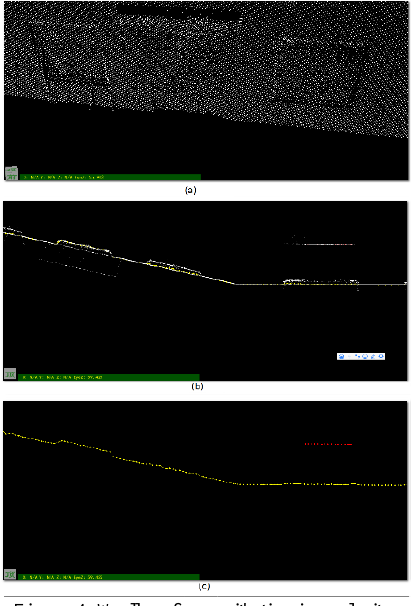
Figure 4. Wall surface with tiny irregularity.